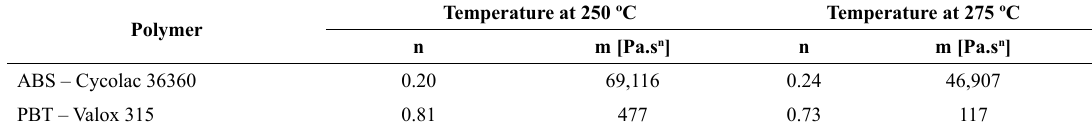
Table 1. Rheological characteristics of PBT and ABS obtained with capillary rheometer at temperatures of 250 and 275 ºC.